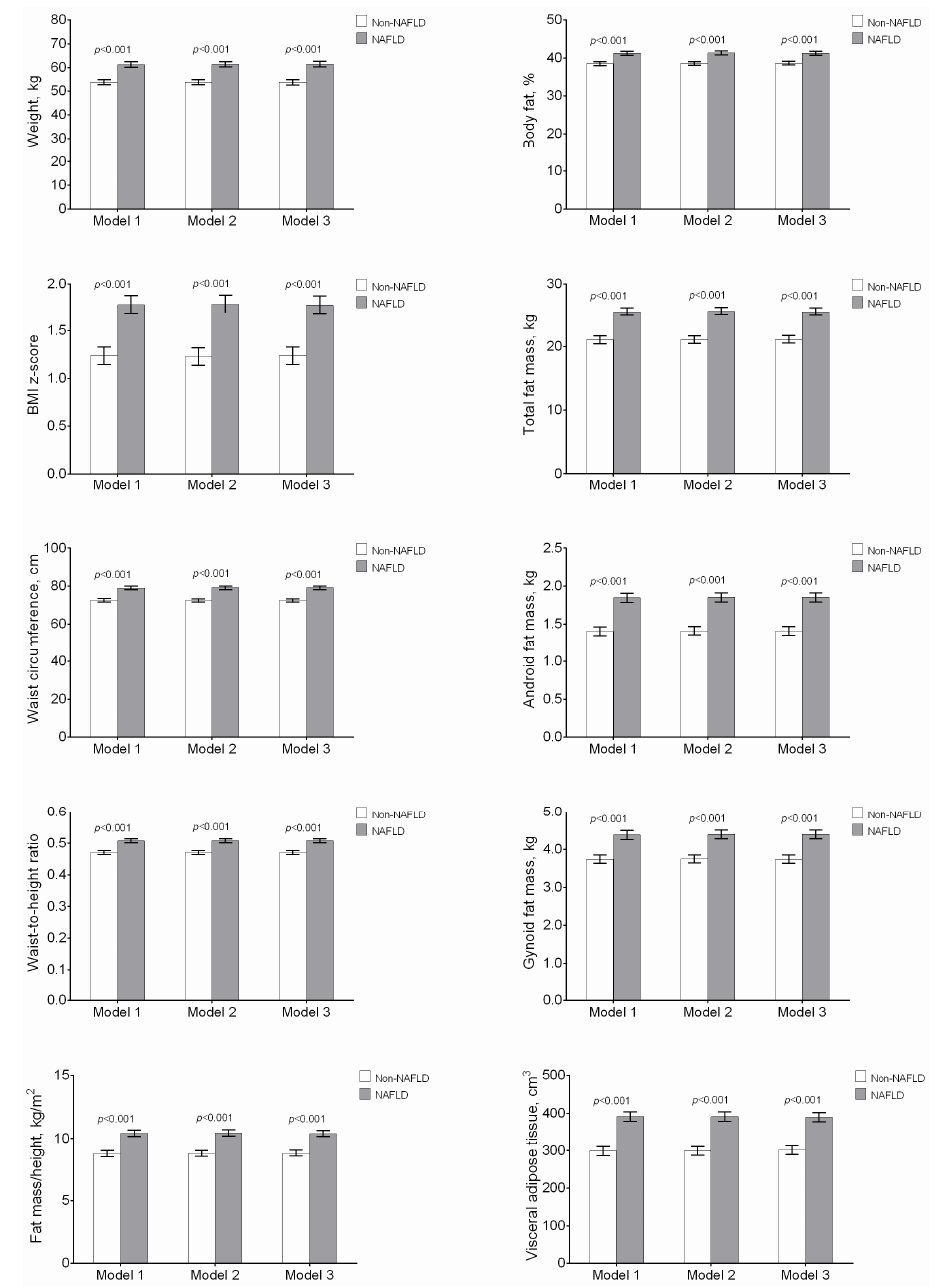
Figure 1. Fat distribution parameters in youth according to the presence or absence of non-alcoholic fatty liver disease (NAFLD). Analysis of covariance (ANCOVA) Model 1: Adjusted for sex, age, puberty stage, and lean mass index; ANCOVA Model 2: Model 1 additionally adjusted for cardiorespiratory fitness (CRF); Model 3: ANCOVA Model 2 additionally adjusted for Mediterranean diet optimal adherence.